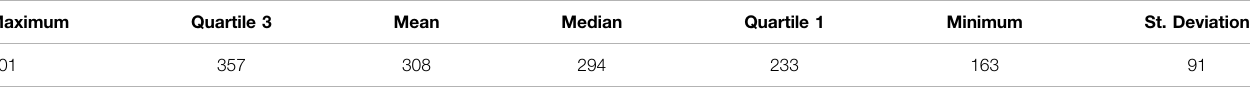
TABLE 1 | General descriptive statistics of the grain size of the used PE, in µm.